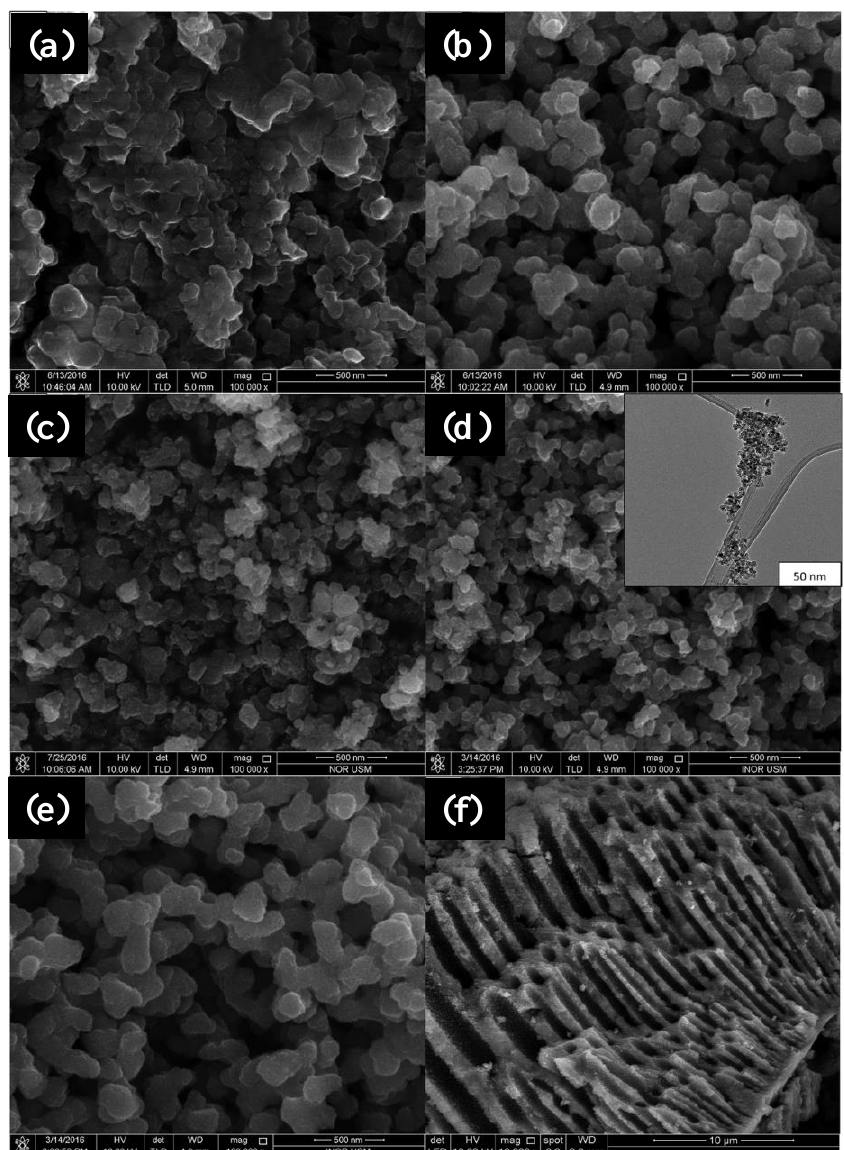
Figure 7. FESEM micrographs of TiO 2 NPs synthesized using ( a ) uncalcined TiO 2 ; ( b ) 0.01 mol titanium tetraisopropoxide (TTIP), pH 5; ( c ) 0.01 mol TTIP, pH 7; ( d ) 0.01 mol TTIP, pH 9, insert: HRTEM image; ( e ) 0.07 mol of TTIP in pH 9; ( f ) pore channels of TiO 2 NPs. Figure adapted with permission from Reference [110]. Copyright 2017 RSC.